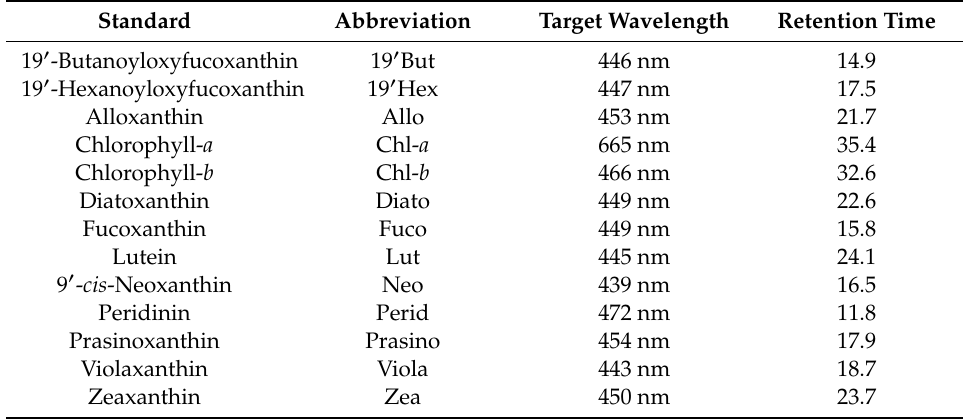
Table 2. Pigment standards.Thirteen most basic pigment standards are used for analysis as required by Mackey et al. [30]. Each vial comes with 2.5 mL at approximately 1 mg / mL from DHI. Certificate of Analysis must be obtained from DHI for the actual concentration of each standard. Retention time is expected to shift slightly depending on the